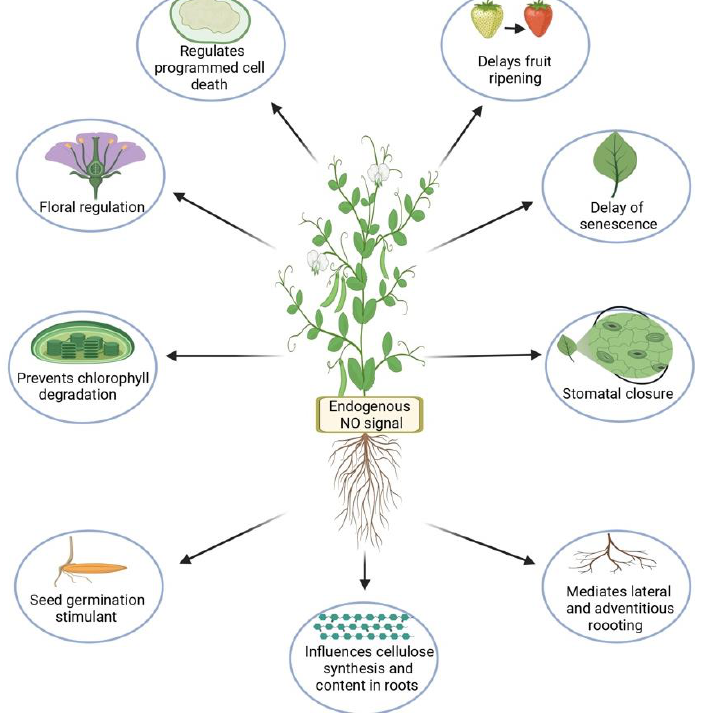
Figure 2. Role of No in plant growth and development. (Made with Biorender.com (accessed on 3 September